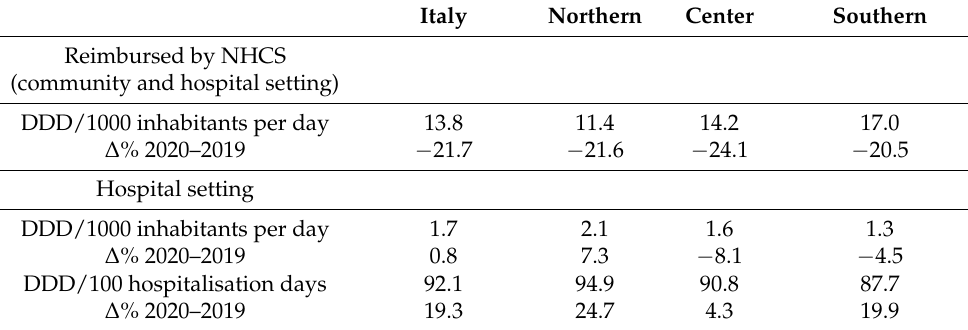
Table 1. Consumption of antibiotics for systemic use (J01) reimbursed by Italian NHCS (community and hospital setting) and antibiotics prescribed exclusively in hospital settings during 2020.